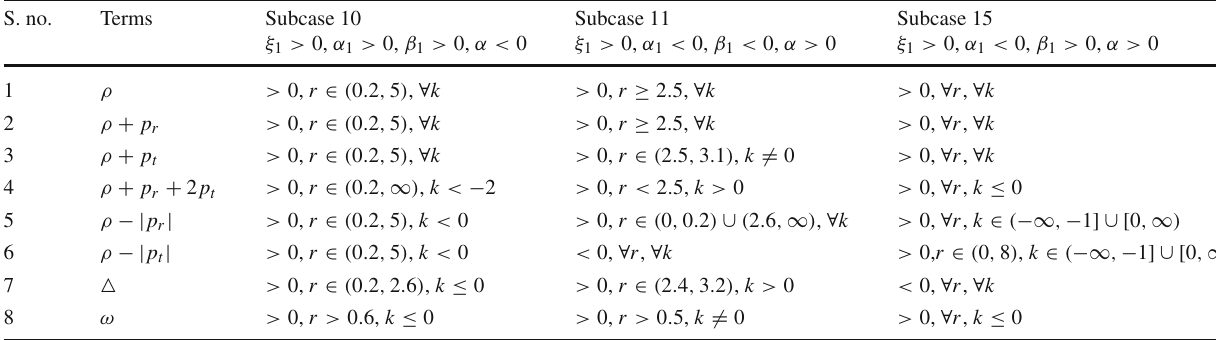
Table 3 Results for Model-I: ρ = α 1 R + β 1 R (cid:2) e ξ 1 R S. no.